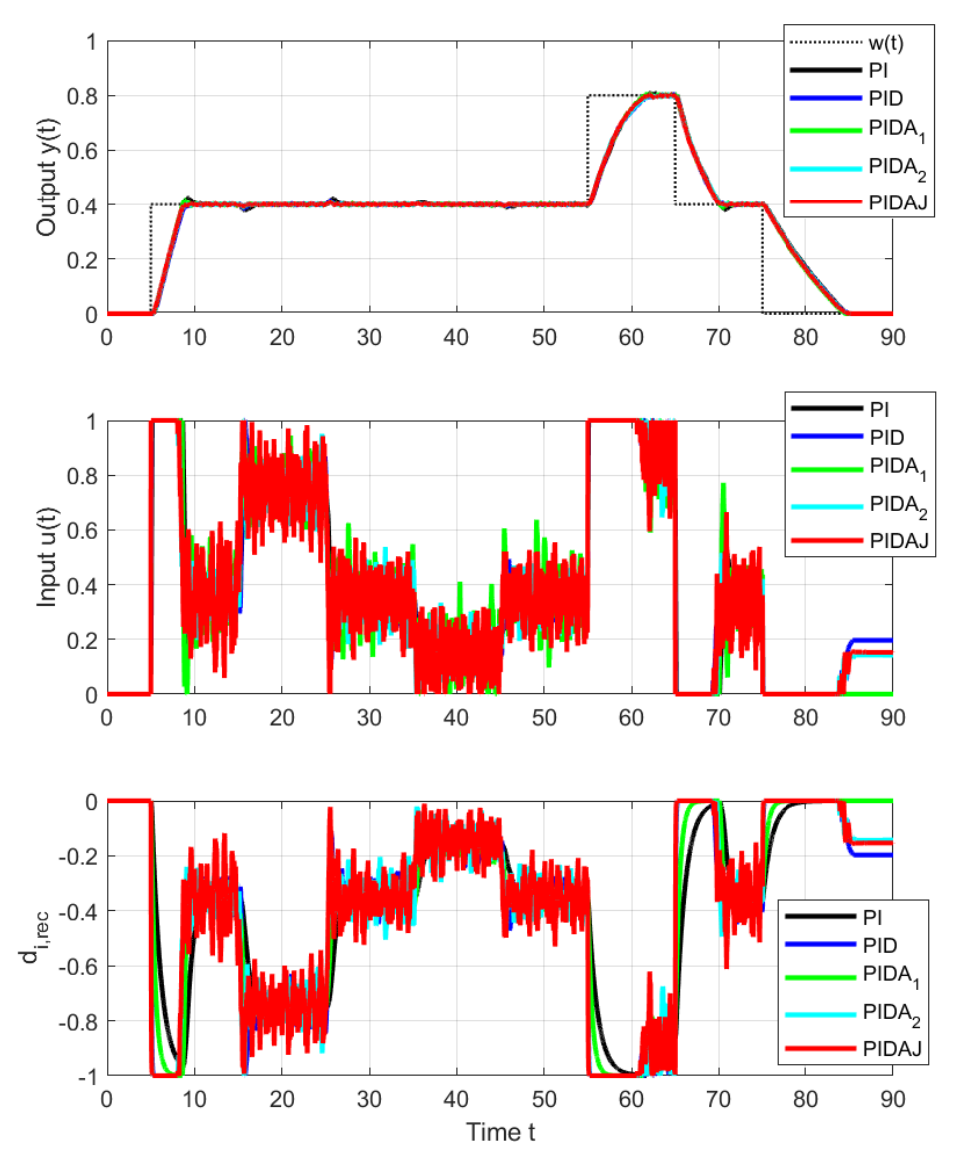
Figure 4. Measured signals from the experiment corresponding to: setpoint step to w = 0.4 at t = 5 s, load step ∆ u = 0.5 at t ∈ [ 15,25 ) s, load step ∆ u = 0 at t ∈ [ 25,35 ) s, load step ∆ u = − 0.25 at t ∈ [ 35,45 ) s, load step ∆ u = 0 at t ∈ [ 45,55 ) s, setpoint step to w = 0.8 at t = 55 s, to w = 0.4 at t = 65 s and to w = 0 at t = 75